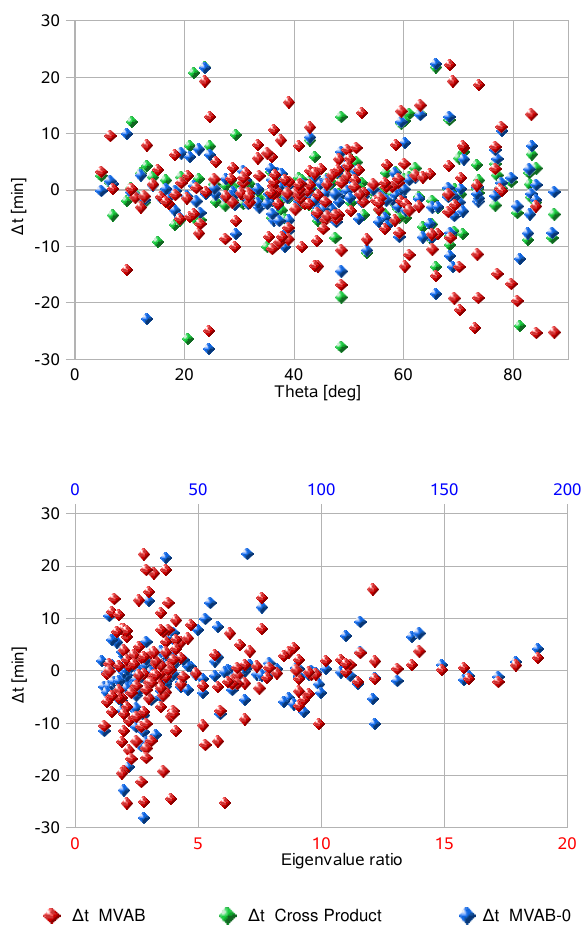
Fig. 5. Top panel : Difference between observed and predicted arrival times as function of the angle θ (the angle between the discontinuity normal and the solar wind velocity - see also Figure 1). Bottom panel: Difference between observed and predicted arrival times as function of eigenvalue ratio for the minimum variance based methods. The vertical axes in both panels show the time differences ∆ t = t model − t observed . In the lower panel, red data points, and the lower vertical axis indicate the λ int /λ min eigenvalue ratio for MVAB, whereas the blue symbols and the upper horizontal axis indicate the corresponding ratio λ max /λ int for the MVAB-0